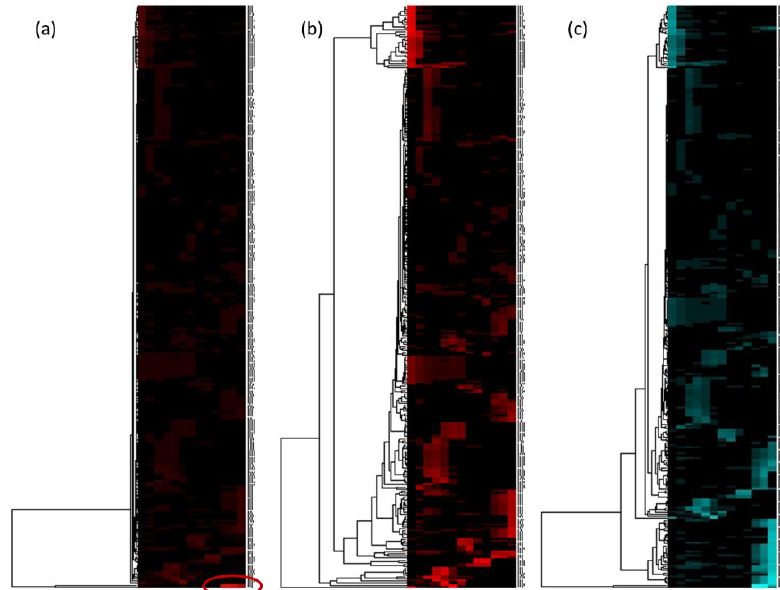
Figure 5. Comparison of heat maps for glycerin model extract: ( a ) without presaturation of glycerin signals. The red circle corresponds to the intense cluster of glycerin ( δ 63.7, 73.1); ( b ) similar to ( a ) with manual suppression in the text file of the two bins 63.7 and 73.1 ppm corresponding to the glycerin signals; ( c ) with presaturation of glycerin signals during 13 C-NMR analysis of F 11 , F 12 , and F 13 .